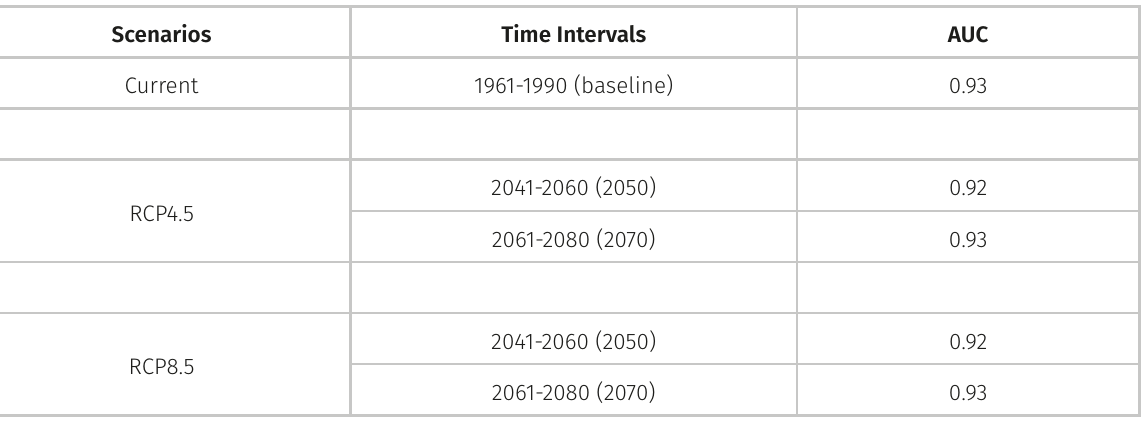
Table II. Absolute and relative values of areas with high potential occurrence (> 0.75).